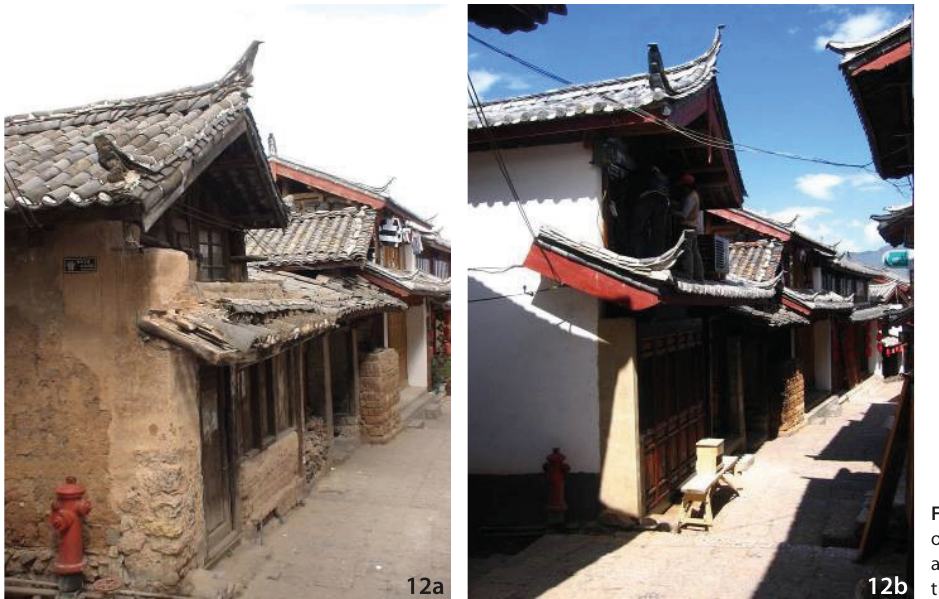
Figure 12a and 12b Comparison of residential houses before and after restoration (Source: the au- thor). 12b